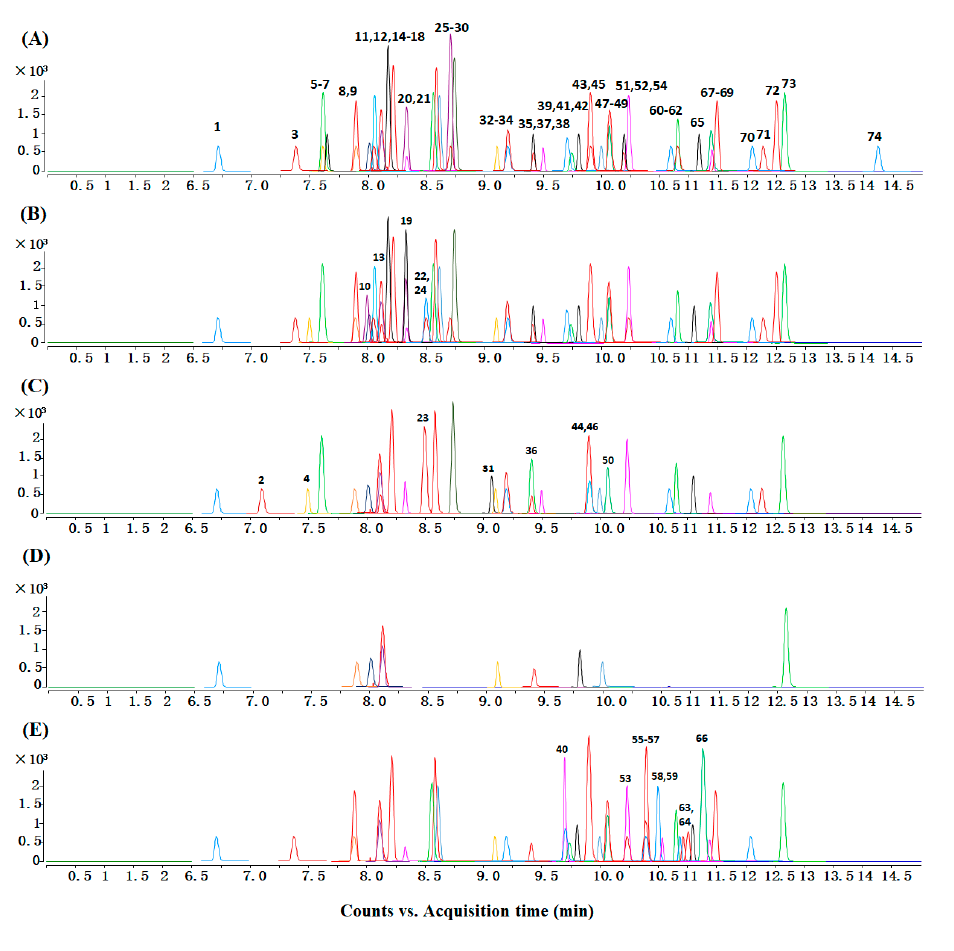
Figure 1. MRM chromatograms of phenolic compounds in ( A ) Brassica rapa ; ( B ) B. oleracea ; ( C ) Eruca ; ( D ) Raphanus ; and ( E ) Nasturtium species. The identity of the peaks are listed in Table